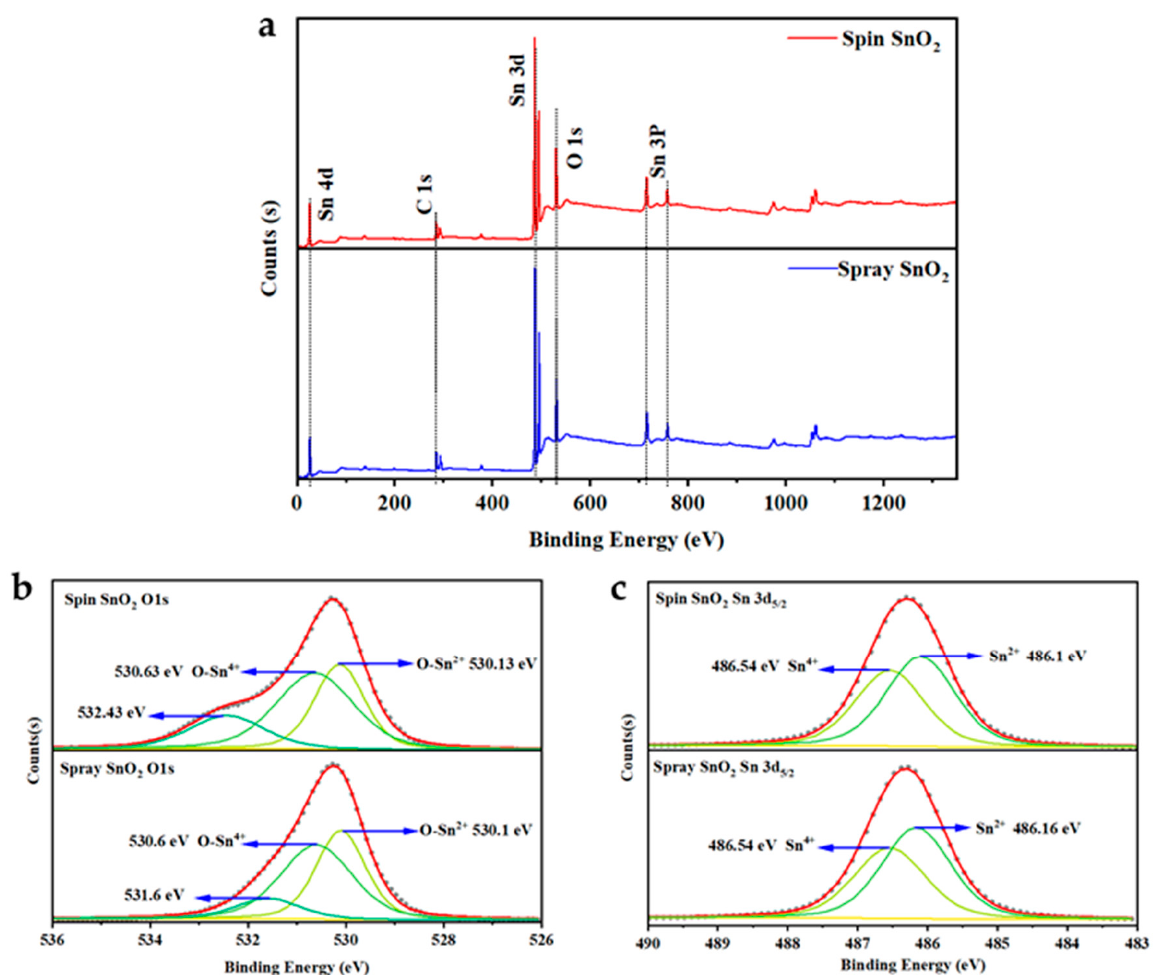
Figure 4. XPS spectra of spin-coated and sprayed SnO 2 films: ( a ) full spectra, ( b ) high-resolution O1s spectra, ( c ) high-resolution Sn3d spectra.